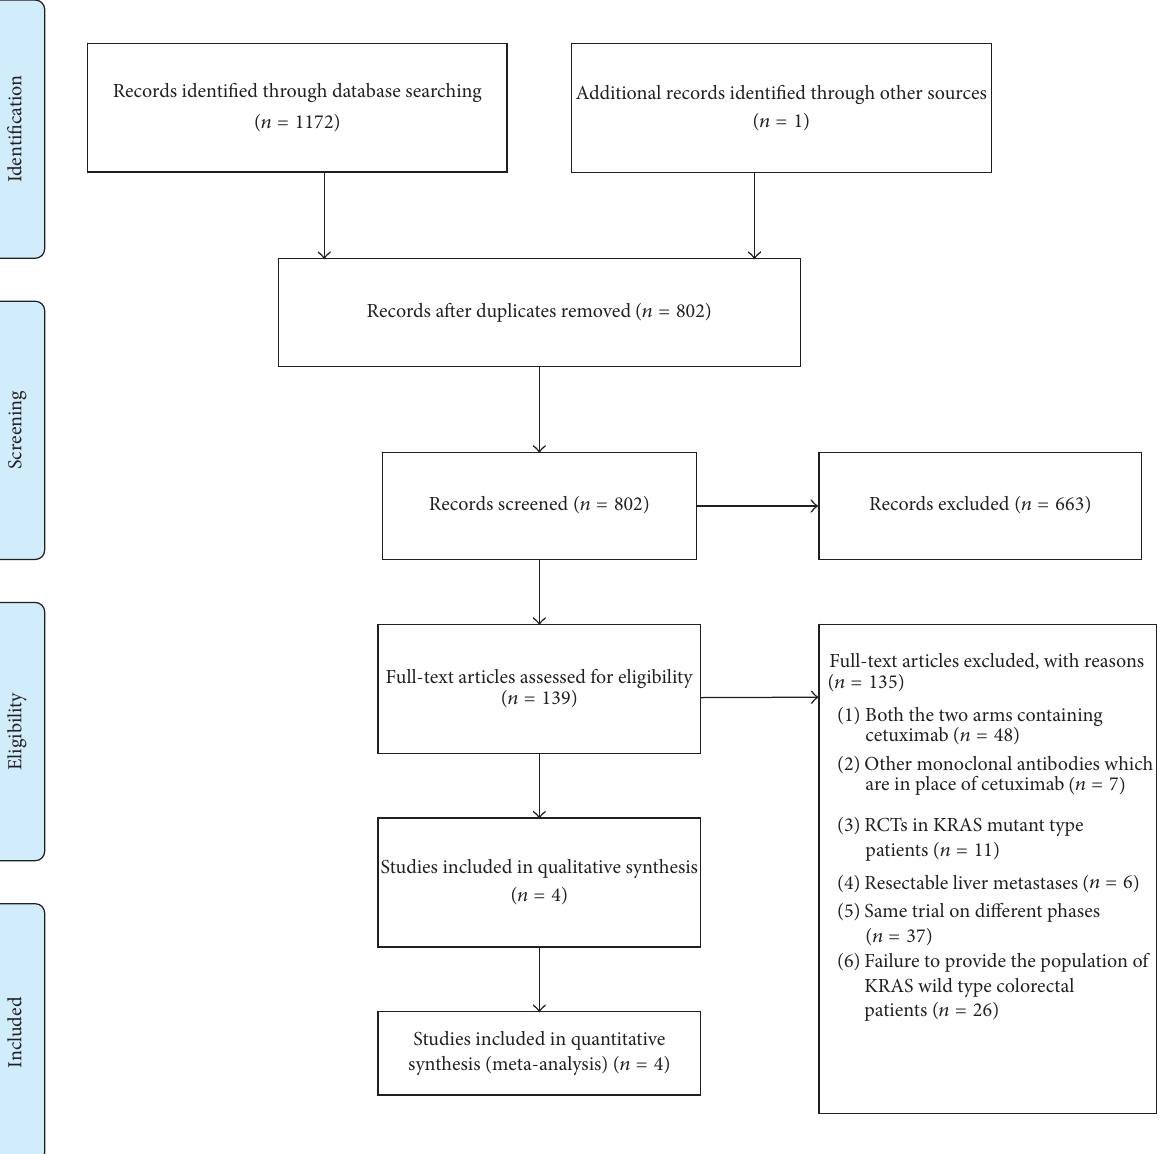
Figure 1: Flowchart of the included studies.